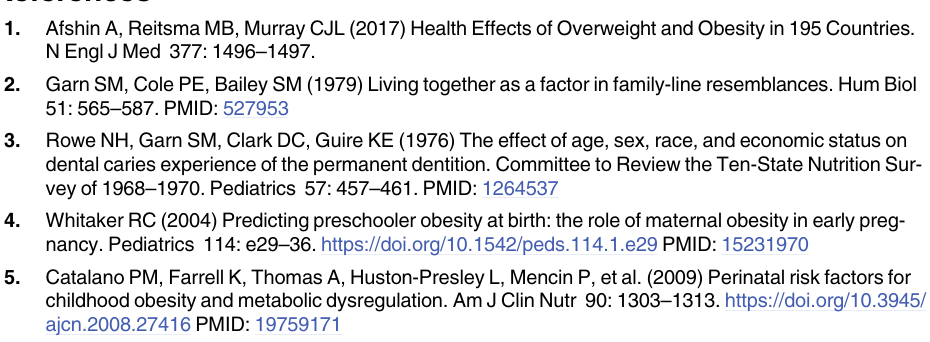
S4 Table. Full list of genes associated with DMRs in common between OBS and ALSPAC cohorts for male (A) and female (B) neonates. S5 Table. Full list of Gene Ontology pathways for biological process based on genes in common between OBS and ALSPAC cohorts in male (A) and female (B)